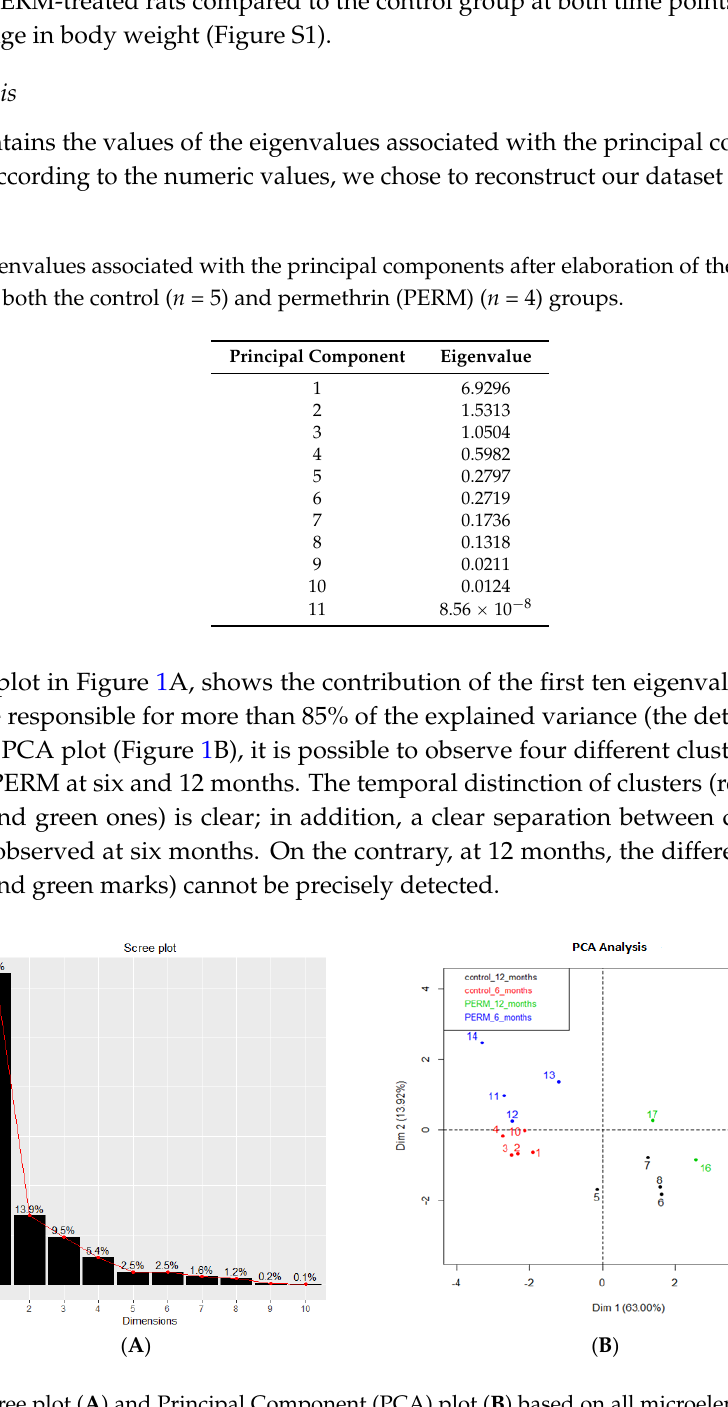
Figure 1. Scree plot ( A ) and Principal Component (PCA) plot ( B ) based on all microelements from hair of control and Permethrin (PERM)-treated rats at six and 12 months of